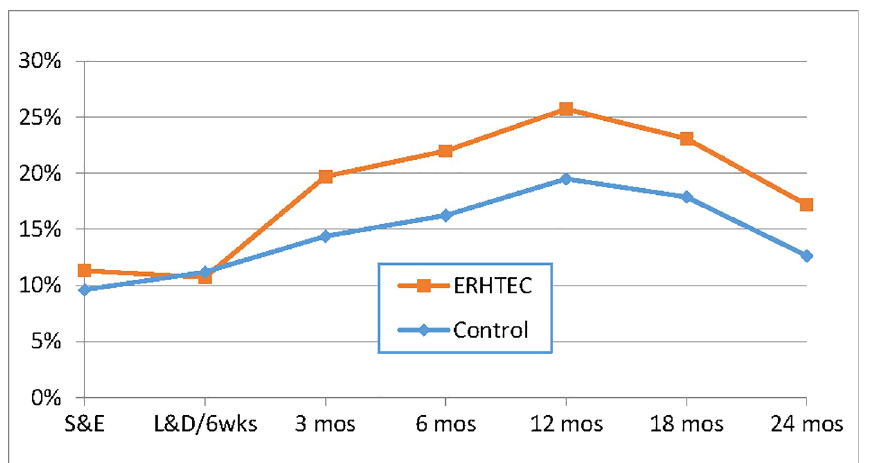
Fig 4. Proportion of women who practiced safer sex through condom use in the last 3 months, by visit. Difference in average change by treatment assignment: p = 0.665 Difference in average follow-up level by treatment assignment: p = 0.026.